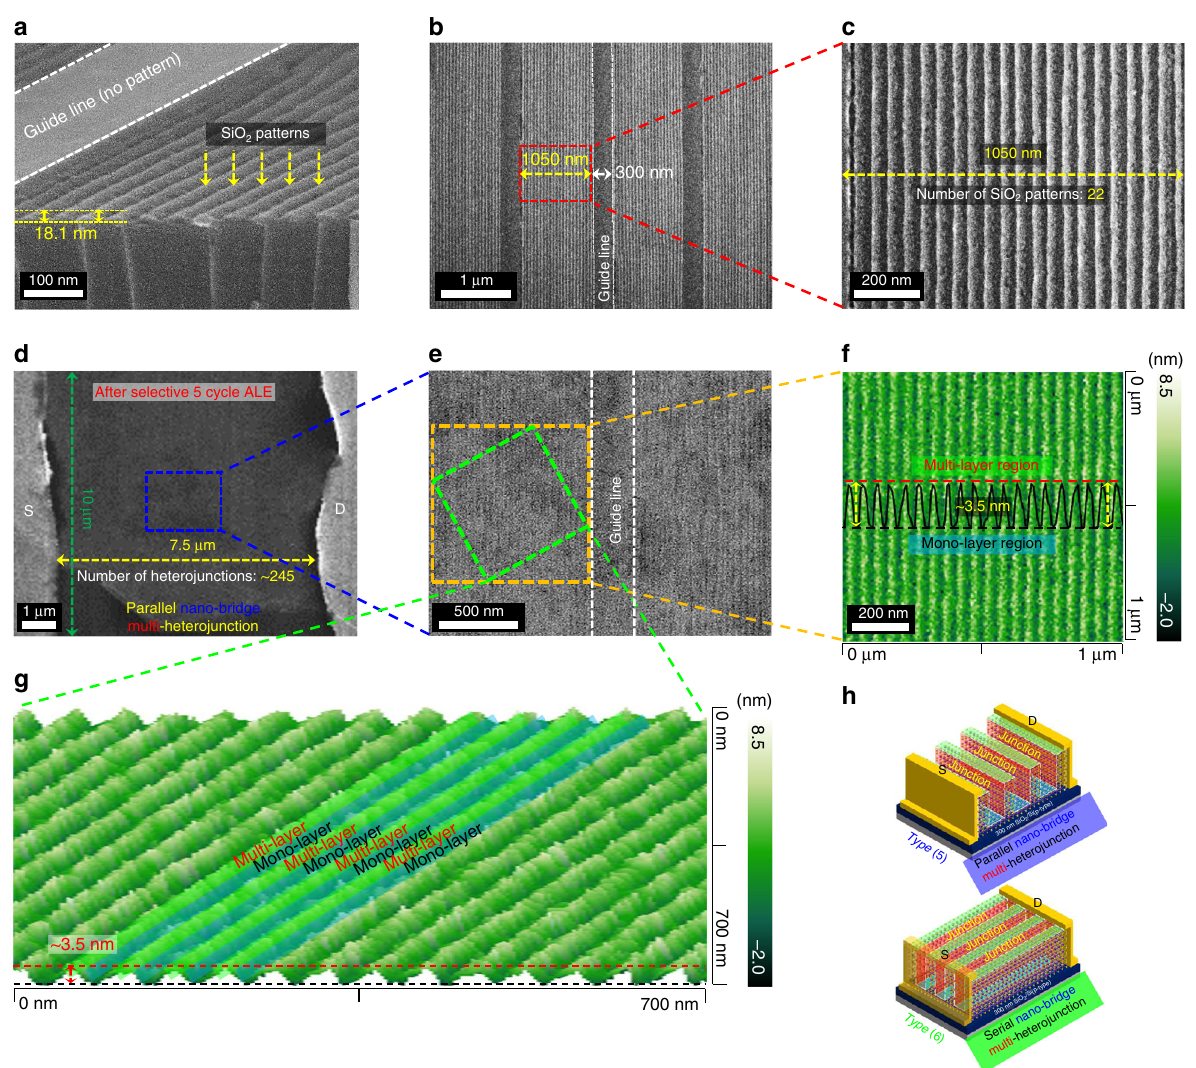
Fig. 2 Structural morphology analysis of MoS 2 FETs with parallel and serial nano-bridge. a Side-view and b top-view fi eld-emission-scanning electron microscope (FE-SEM) images of 25 nm (50 nm pitch) SiO 2 line patterns fabricated by a nano-patterning process on multi-layer MoS 2 FETs. c High magni fi cation FE-SEM image for the red box area in b . d FE-SEM image (after the removal of SiO 2 mask) of multi-heterojunctions after the selective 5 ALE cycles on the multi-layer MoS 2 FET patterned with 50 nm pitch SiO 2 line nano-patterns. e High magni fi cation FE-SEM image for the blue box area in d . f AFM thickness analysis of the multiple MoS 2 mono-/multi-layer heterojunction for the orange box area in e . g 3D AFM image for the green box area in e . h The schematic drawing of MoS 2 FETs fabricated with parallel nano-bridge multi-heterojunction [Type (5)] and serial nano-bridge multi-heterojunction [Type